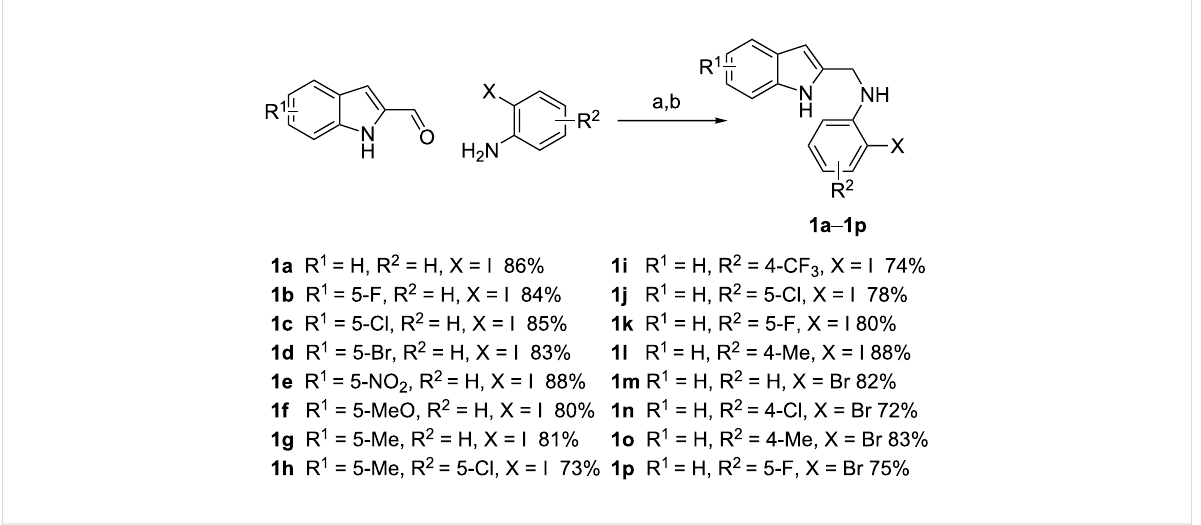
Scheme 1: Reagents and conditions: (a) CF 3 COOH, anhydrous dichloromethane, reflux; (b) NaBH 4 , MeOH.